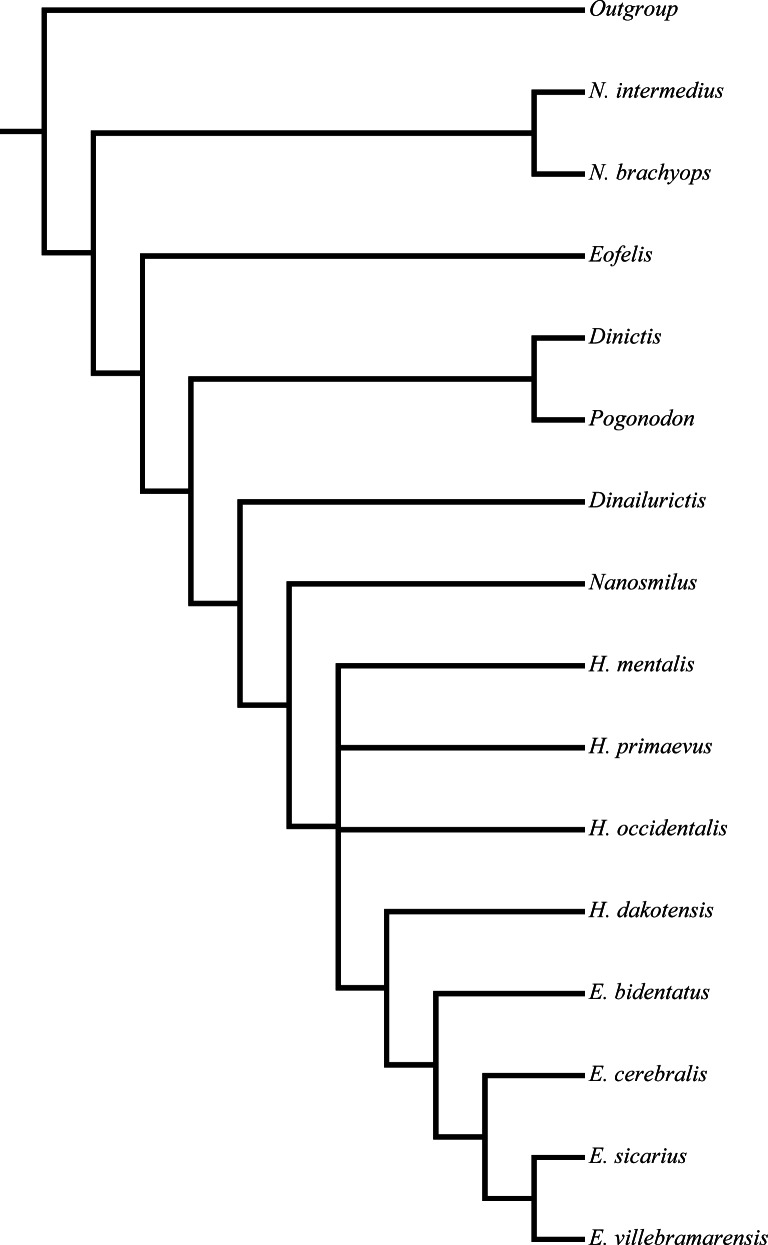
Peigné (2003) nimravid phylogeny.Recovered phylogenetic hypothesis of Peigné (2003). Modified from Peigné (2003: Fig. 14).